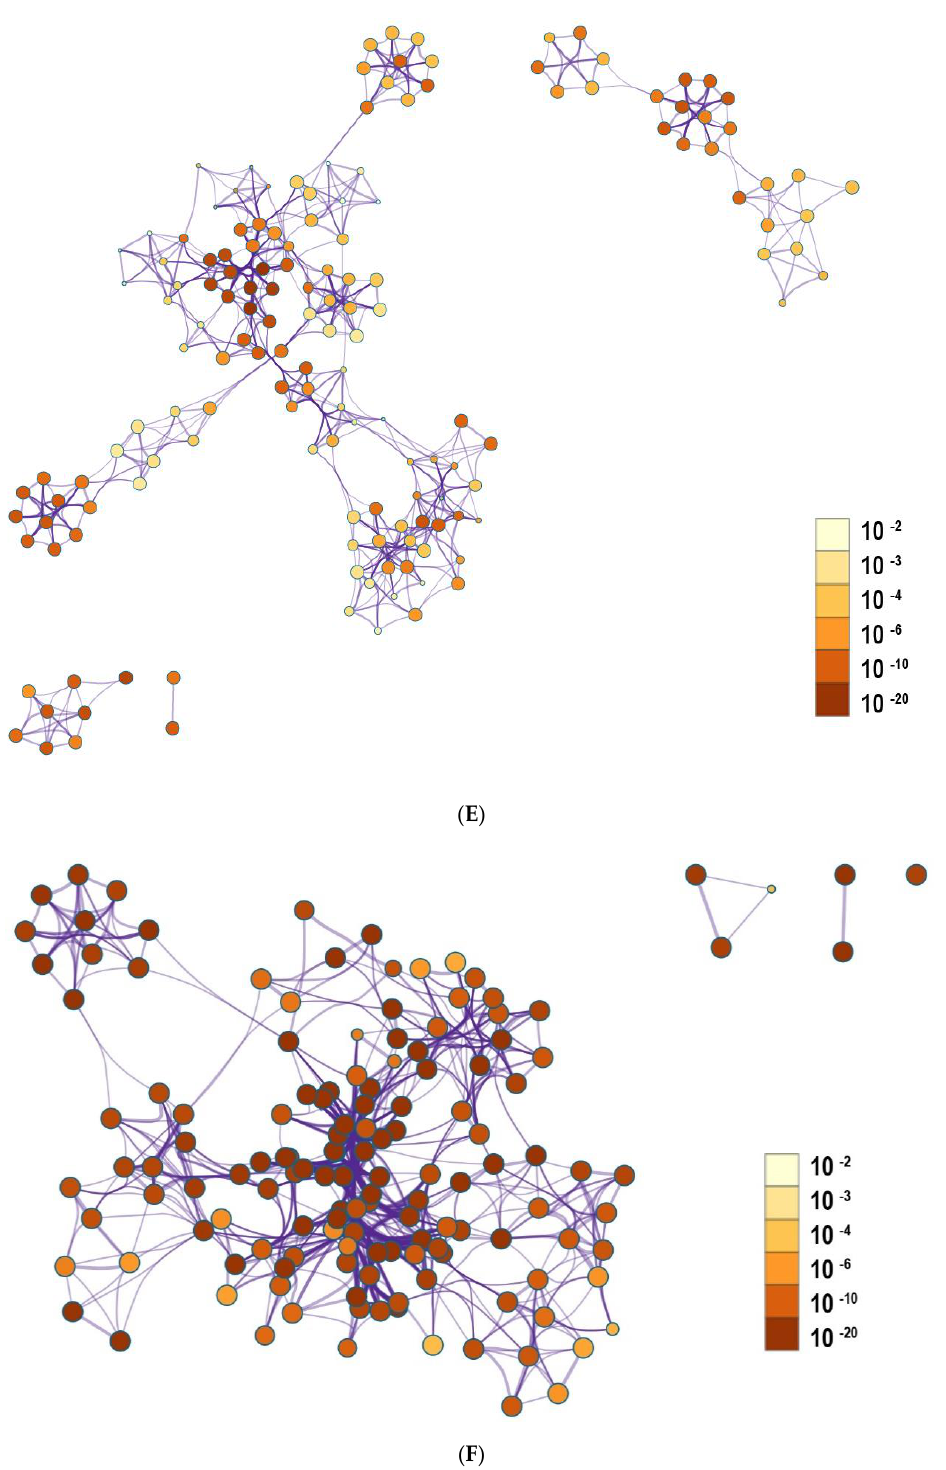
Figure 4. The enrichment analysis data from Metascape. ( A , B ) Bar plot of enriched terms (colored by cluster ID) for down-regulated DEGs ( A ) and up-regulated DEGs ( B ). ( C , D ) The network of enriched terms (colored by cluster) for down-regulated DEGs ( C ) and up-regulated DEGs ( D ). ( E , F ) Network plot of enriched terms (colored by p -value) for down-regulated DEGs ( E ) and up-regulated DEGs ( F